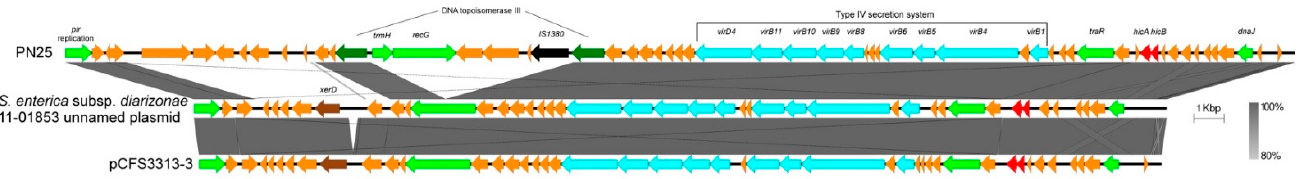
Figure 7. Linear plasmid map showing the T4SS units in plasmid pCFS3313-3. Conservation and synteny of IncX4 plasmid pCFS3313-3 with plasmid PN25 and an unnamed plasmid from S. enterica subsp. diarizonae 11-01583. Along with the similarity in T4SS, the plasmids also shared similar replicase and transposon elements denoting a higher degree of conservation. Colour scheme: transposons and insertion elements (black), integrons and integrases (brown), toxins/antitoxins (red), virulence genes (T4SS unit) (cyan), and genes of interest (green).